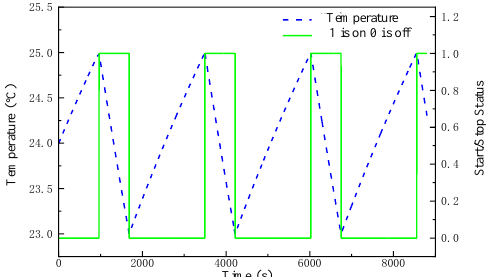
Figure 2. Diagram of temperature and air-conditioning start – stop state over time.